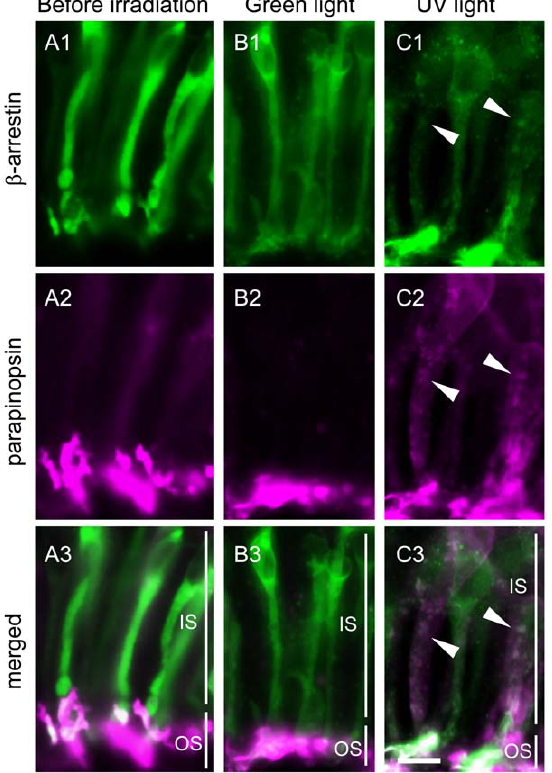
Figure 4. Light-regulated translocation of both b -arrestin and parapinopsin in the pineal photoreceptor cells. Parapinopsin- containing photoreceptor cells in the dorsal region of the isolated pineal organs before irradiation (A), after irradiation with green light for 6 hours (B) and after irradiation with UV light for 6 hours (C). Panels Ai– Ci and panels Aii–Cii show b -arrestin (green) and parapinopsin (magenta), respectively. Panels Aiii–Ciii are merged images of both immunoreactivities. Many granules in the inner segment were stained by antibodies to both parapinopsin and b -arrestin (arrowheads in Ci–iii). IS, inner segment; OS, outer segment. Scale bars, 10 m